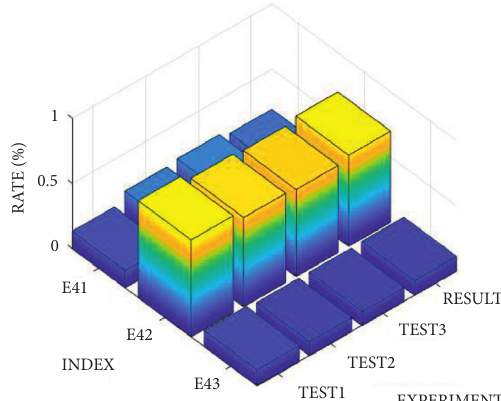
Figure 14: Proportion of various indicators of vehicles leaving the road section.